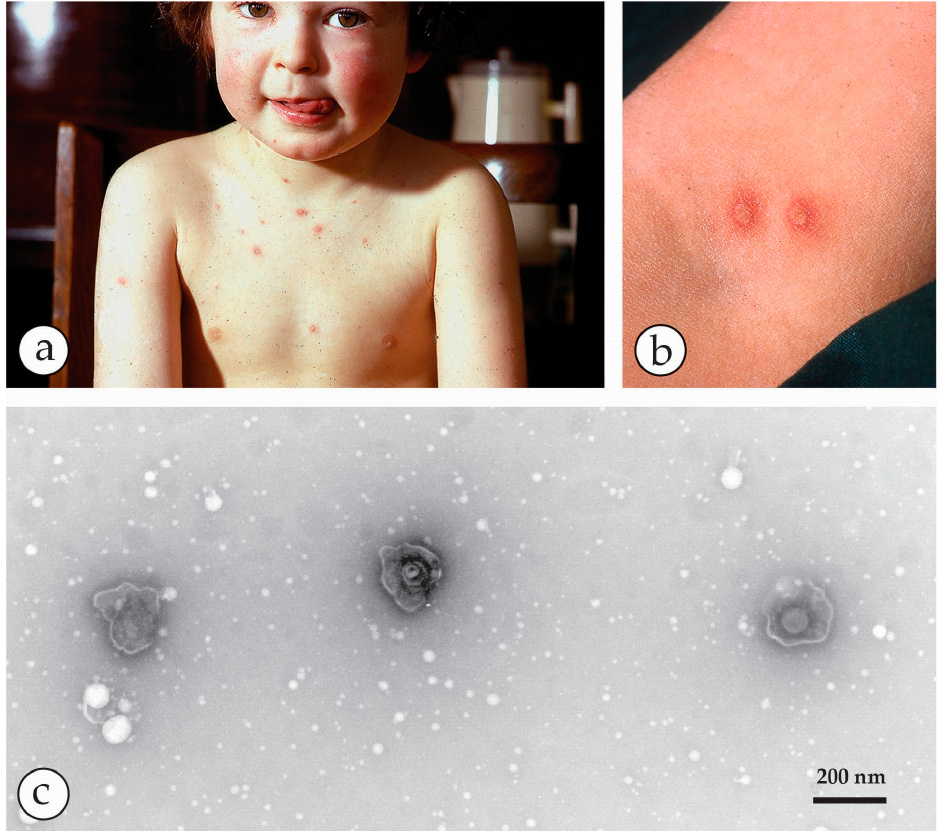
Figure 10. Chickenpox, a common, mild febrile rash in childhood. ( a ) Clinical chickenpox in a five-year old child. The lesions are mostly on the trunk. ( b ) Close-up of vesicles on the arm. They are more superficial compared with the deep-seated OPV or specifically those of smallpox. ( c ) NS-DEM of the clean vesicle fluid shows three herpesviruses. The labile virions are penetrated by the UAc stain and reveal ruptured envelopes containing the hexagonal central 110 nm